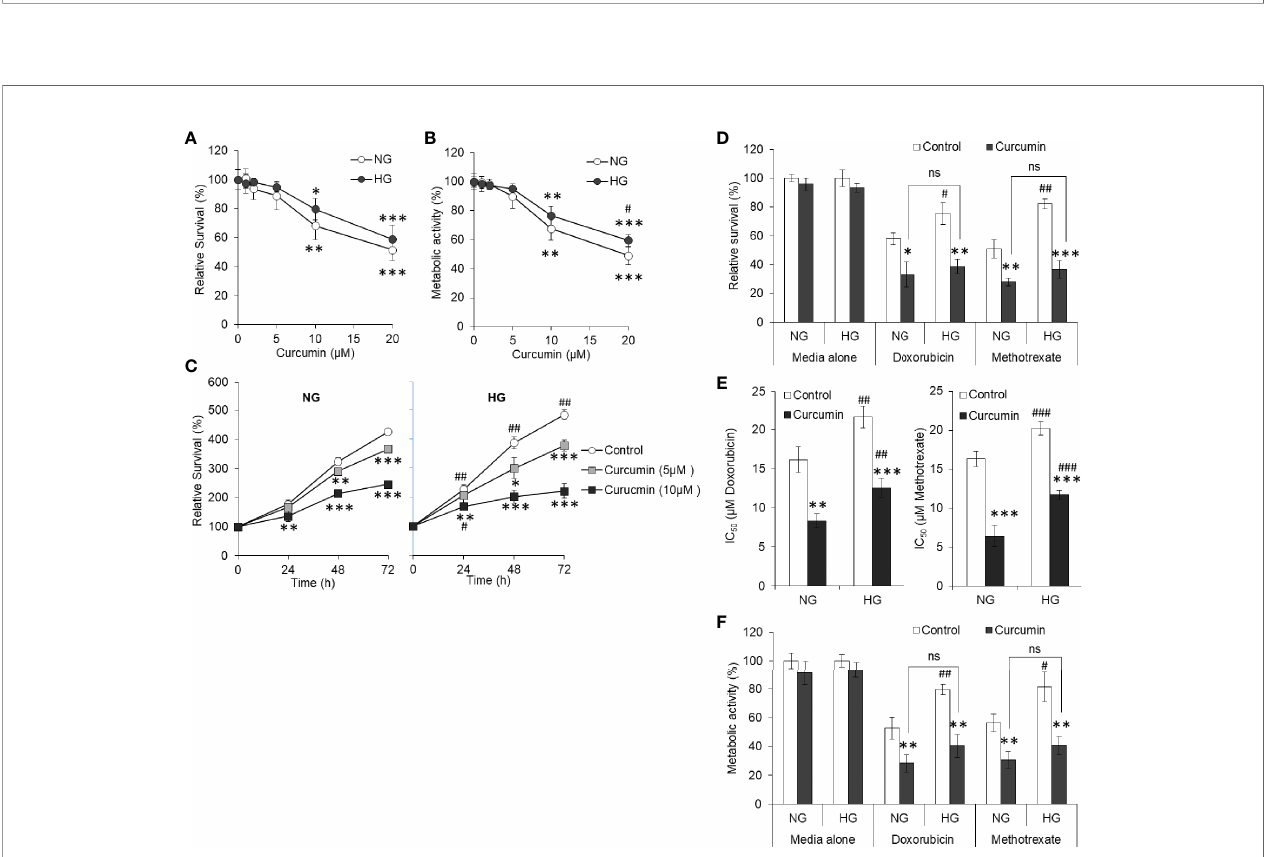
FIGURE 4 | Curcumin resists the hyperglycemia-induced chemoresistance. HepG2 cells incubated in NG or HG medium with indicated concentration of curcumin for 24 h followed by estimation of cell survival (A) and metabolic activity (B) . In time kinetic study, cell survival was estimated after indicated incubation period in NG or HG medium alone or containing 5 or 10 µM curcumin (C) . Cells were incubated in NG or HG medium containing either 5 µM curcumin, anticancer drugs (15 µM), or their combinations for 24 h followed by estimation of cell survival (D) , calculation of IC 50 (E) , and estimation of metabolic activity (F) . The values shown are Mean ± SD of three independent experiments conducted in triplicate. * p < 0.05, ** p < 0.01, *** p < 0.001 vs values of cells of control group not treated with curcumin. # p < 0.05, ## p < 0.01, ### p < 0.001 vs values of cells incubated in NG medium. ns, not signi fi